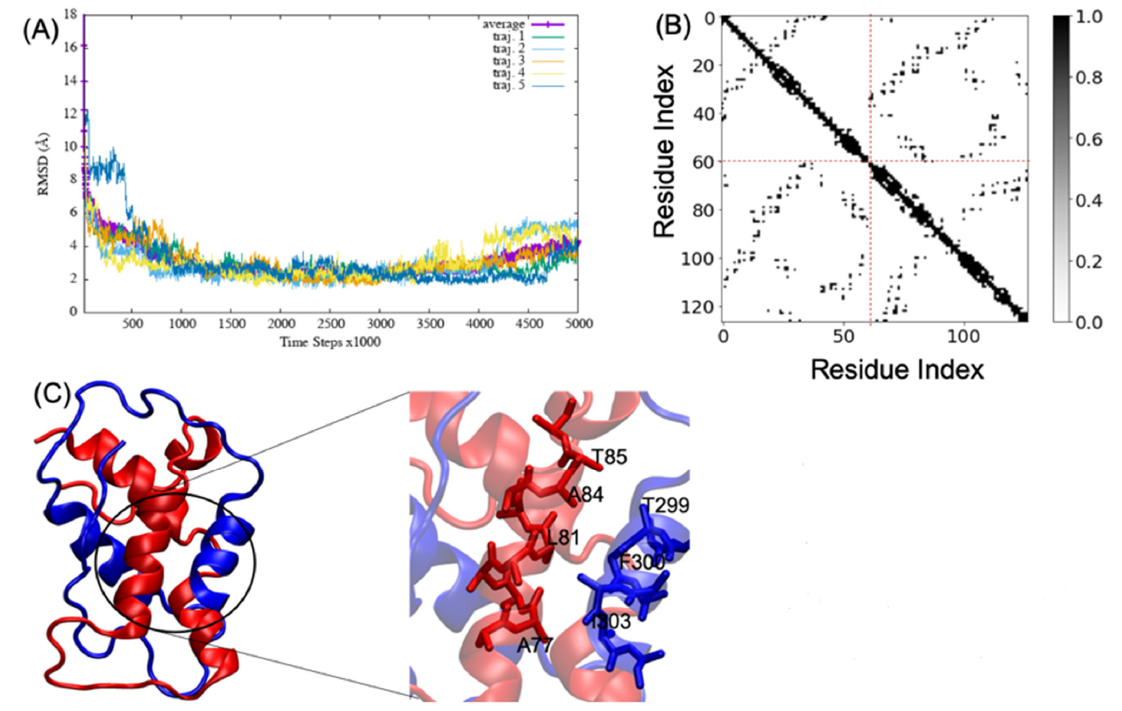
Figure 8. Successful association between the N-terminal domain of D2R and the C-terminal domain of A2aR. ( A ) shows the root mean square deviation (RMSD) over five trajectories and its average; ( B ) indicates the residue contact maps where the dashed lines limit the two monomers; residues 1 to 61 represent the A2AR, and residues 62 through 127 represent D2R; ( C ) shows a snapshot of the complex A2AR (blue) and D2R (red). A few residues at the interacting interface between A2AR and D2R are zoomed out to showcase their interactions. We visualized the structures by using the VMD program.